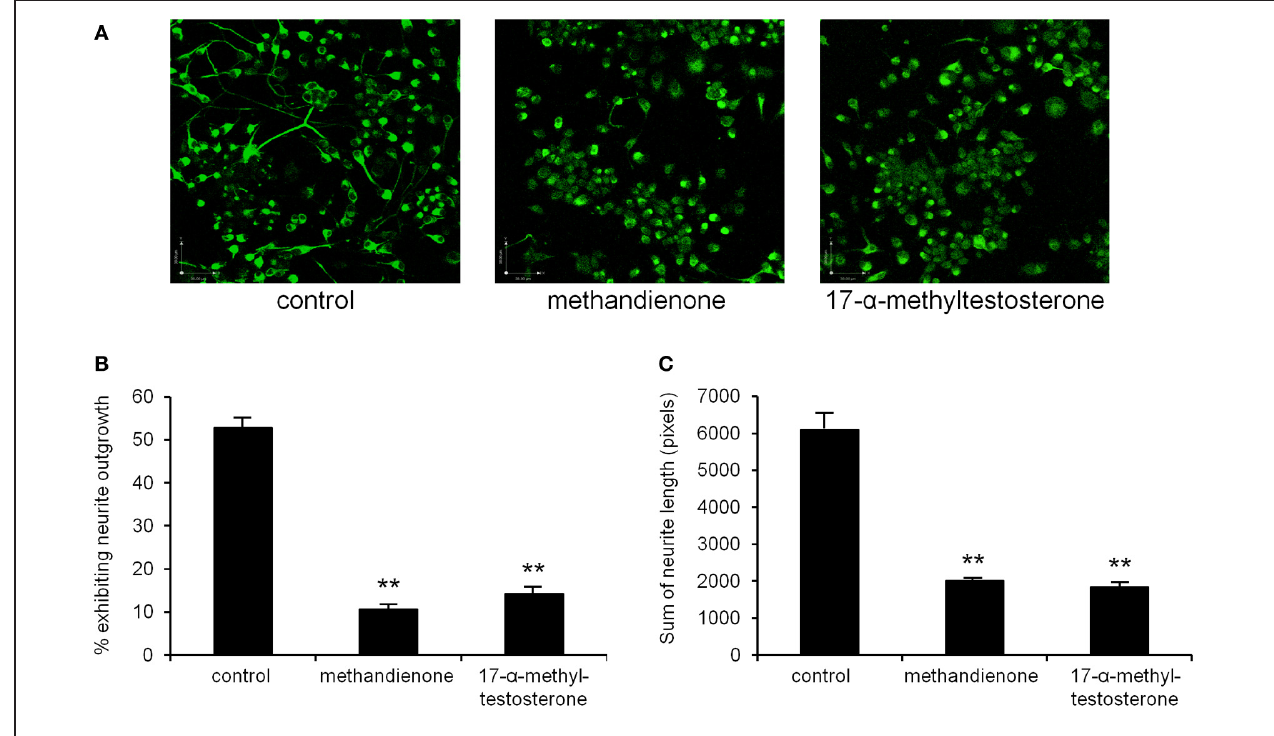
as a percentage of the total number of cells counted ( Y-axis ). Experiments were repeated at least three times and data expressed as mean ± SD ( ∗∗ P ≤ 0 . 01). These AAS demonstrate toxic effects on formed neurite networks in differentiated PC12 (B). Average of the sums of neurite length for identified neurite bearing cells in 10 high-power fields ( Y-axis ). Experiments were repeated at least three times and data expressed as mean ± SD ( ∗∗ P ≤ 0 . 01) (C)